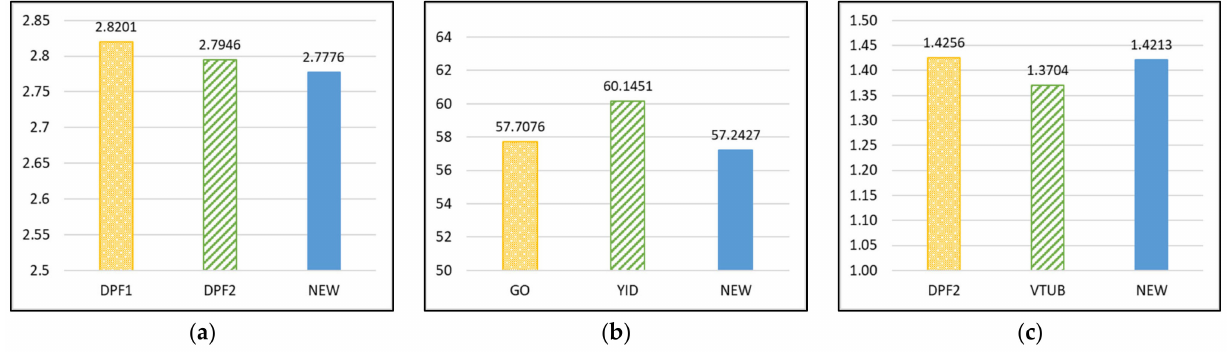
Figure 1. Three criteria values of top three models for dataset 1. ( a ) MSE; ( b ) PRR; ( c ) PP.